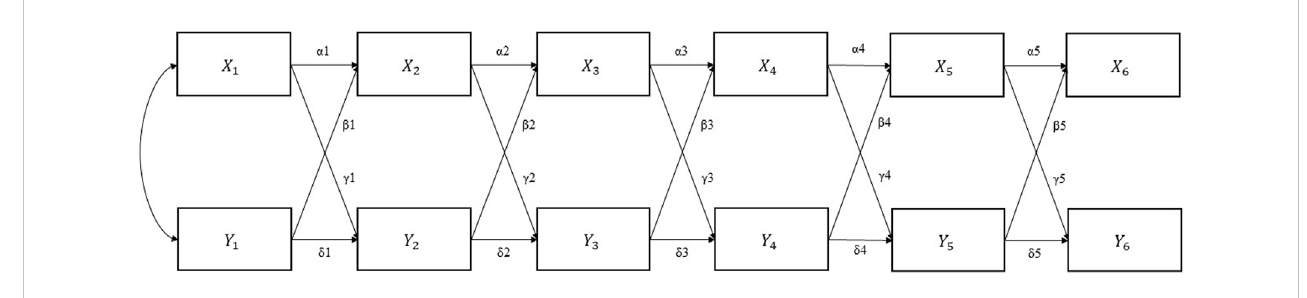
Conceptual path diagram of the CLPM with six waves.